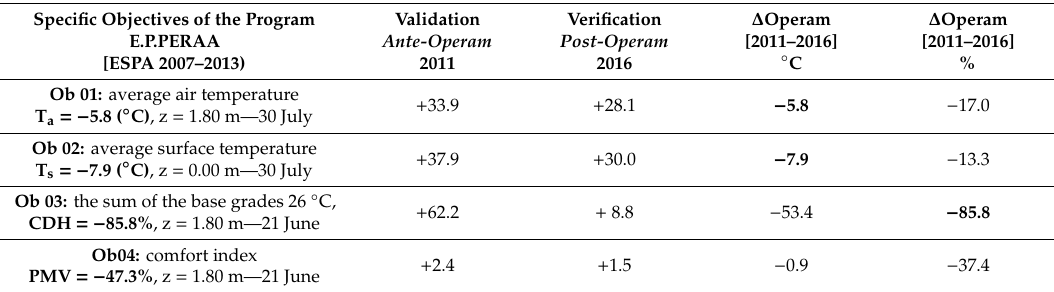
Table 1. The validation and verification of ante and post-operam comparison of the simulation results to the specific objectives of the ESPA program (data in-output of a typical warm summer day 21 June and the hottest day of the year 30 July).